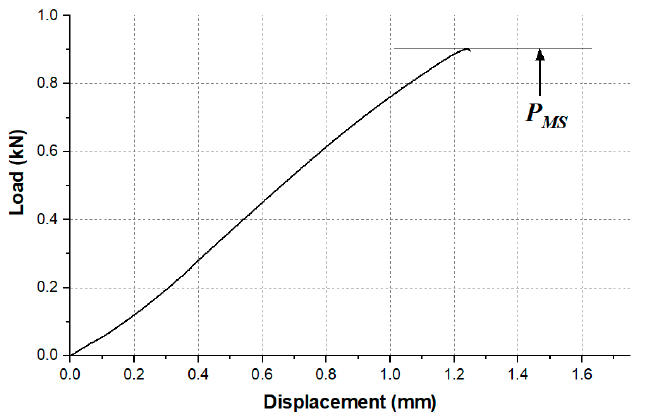
Figure 2. Example of load displacement curve of a quasi-static test.